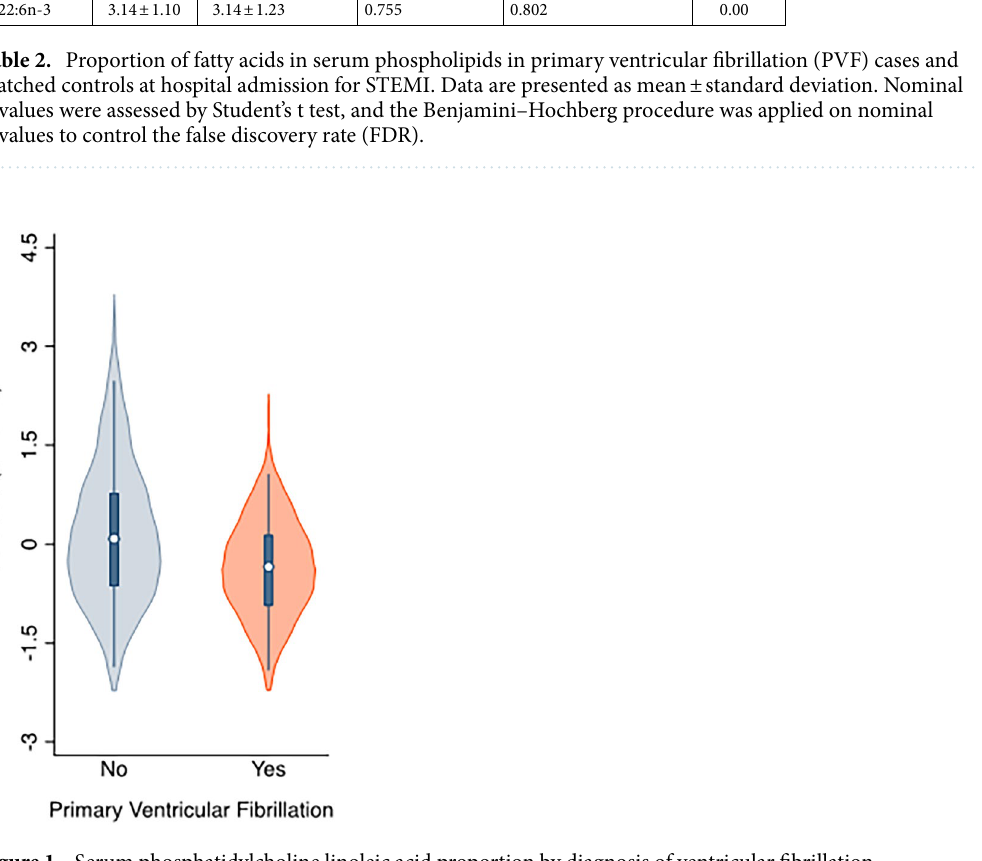
Figure 1. Serum phosphatidylcholine linoleic acid proportion by diagnosis of ventricular